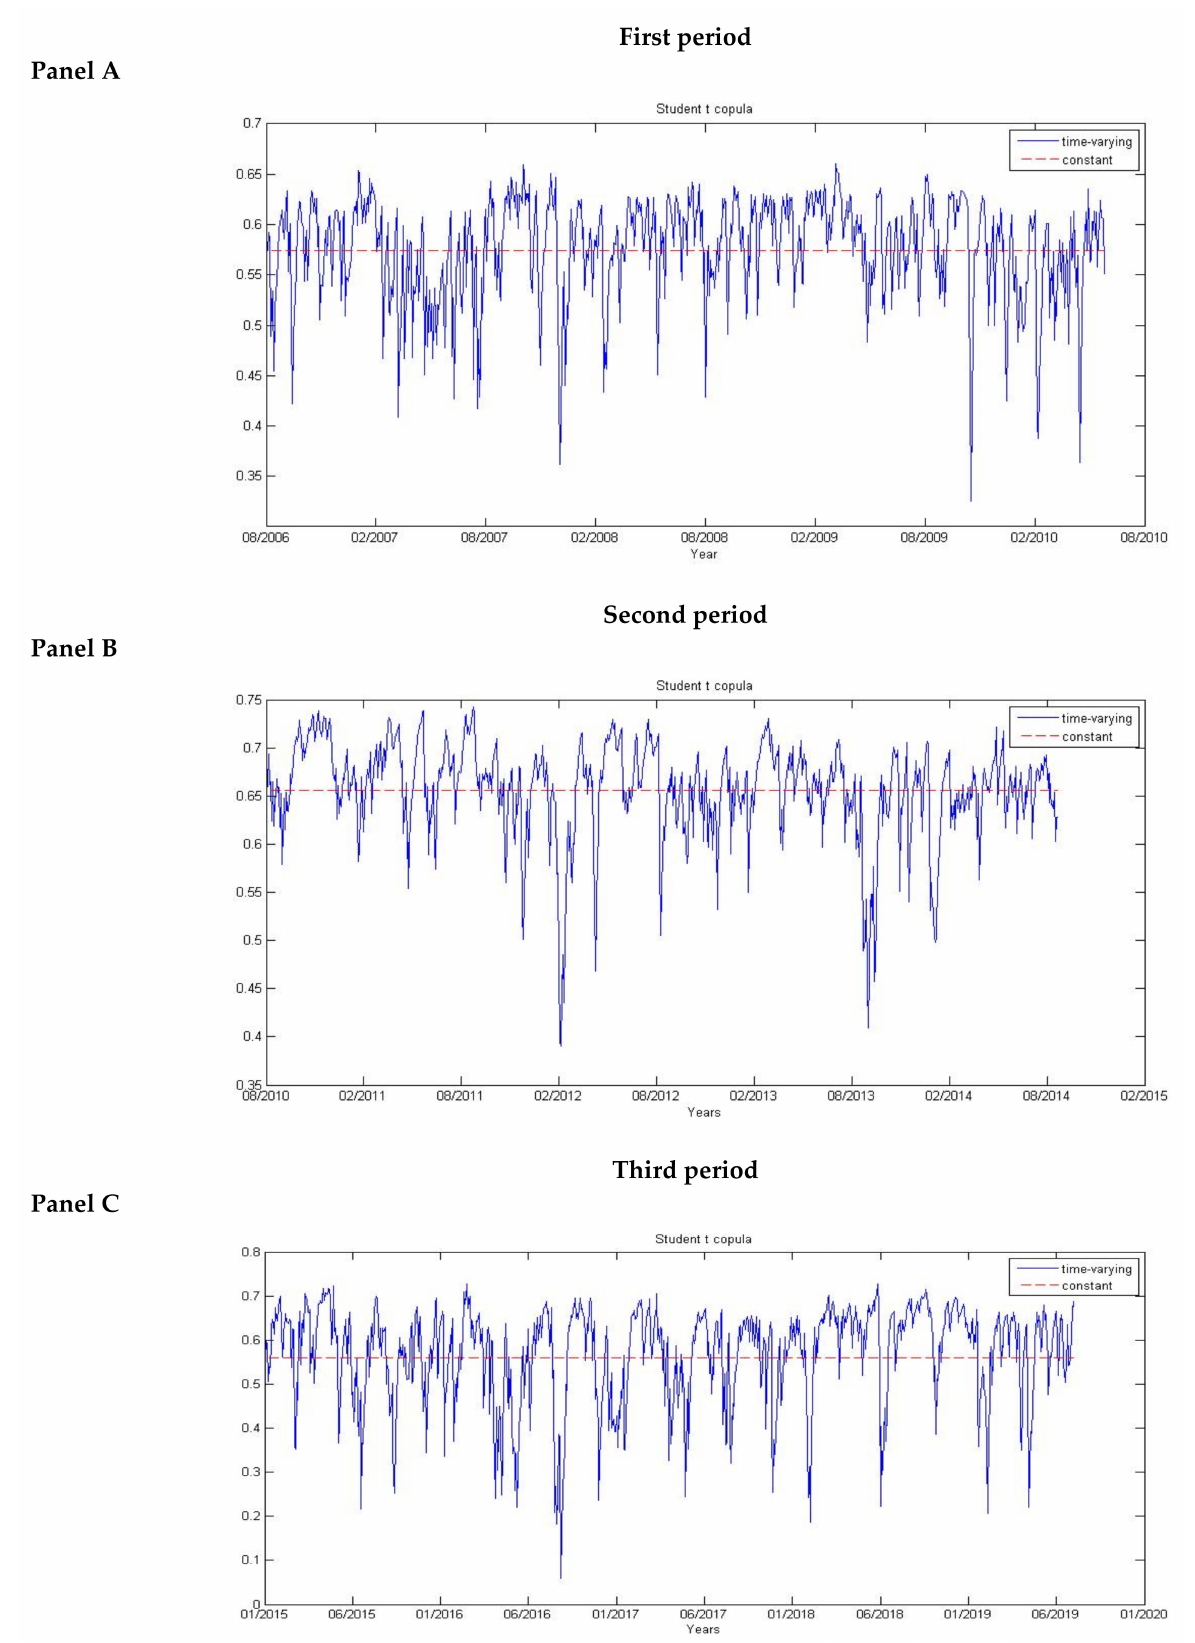
Figure 3. Time varying Student t copula for Kansas-MATIF price